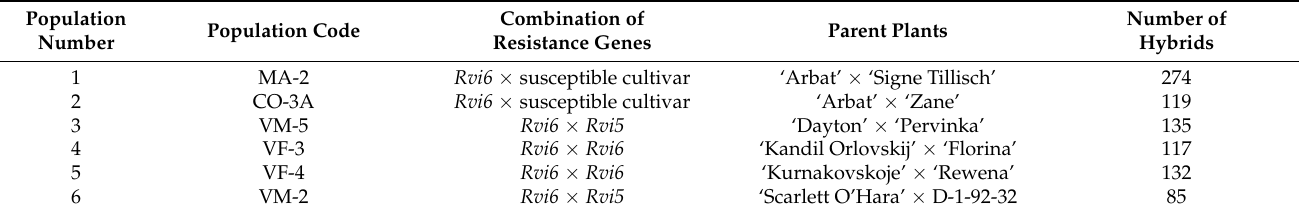
Table 1. Characterization of apple hybrid populations.